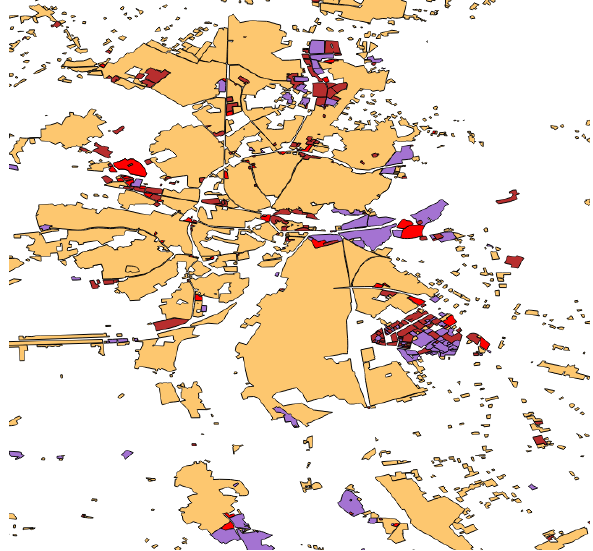
Figure 1. OSM built-up features for Oldenburg, Germany (light orange = “residential”, violet = “industrial”, brown = “commercial”, red = “retail”, grey =